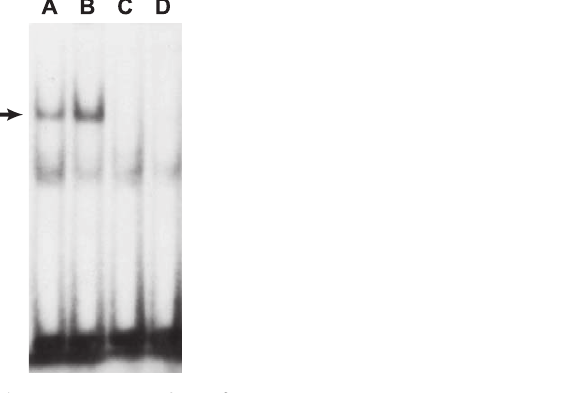
Figure 5. EMSA Analysis of CUL5 SNP6 A/G Nuclear extracts from human T lymphocytes induced by IL-4 were bound to the oligonucleotide containing the SNP6 A allele (lane A) or G allele (lane B), without cold competitors. Lane C contained nuclear extracts, SNP6 A allele probe, and a 100-fold excess of its cold probe as competitor. Lane D contained nuclear extracts, SNP6 G allele probe, and a 100-fold excess of its cold probe as competitor. An arrow indicates the band showing differential binding of nuclear factor(s) to the oligonu-